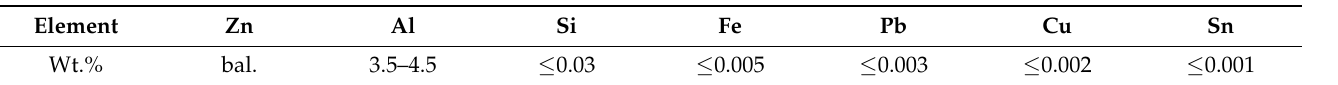
Table 2. Chemical composition of the wires according to the material data sheet of the manufacturer (Grillo-Werke AG, Duisburg, Germany).